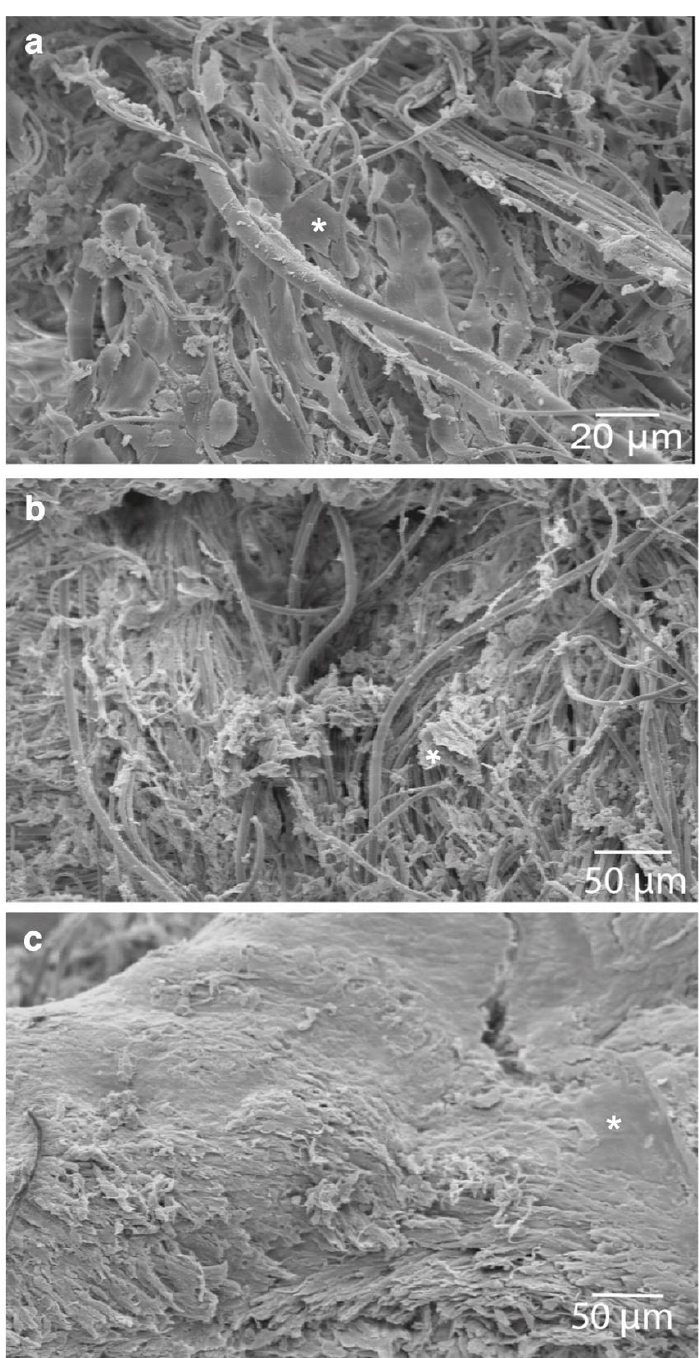
Figure 3. Ultrastructure and morphologic changes of C2C12 cells (*) on the spider silk scaffold visualized by scanning electron microscopy: ( a ) 3 h after cell seeding on the scaffold, ( b ) controls after 2 weeks without bioreactor cultivation and ( c ) 2 weeks after bioreactor cultivation.